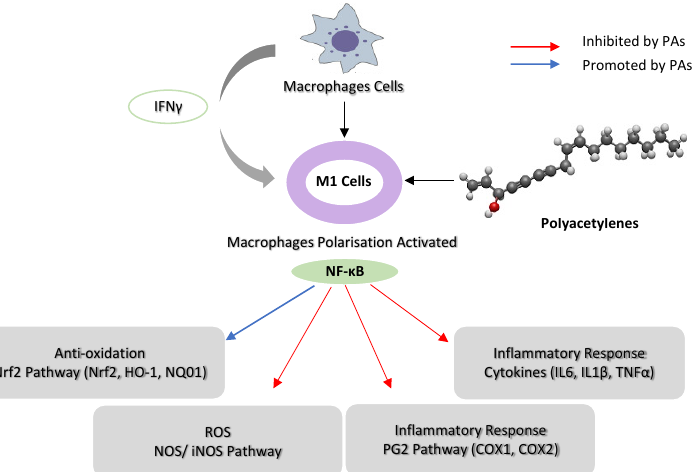
Figure 3. Schematic representation of the possible mechanism of immunoregulation activity of poly-acetylenes (PAs) in macrophages. (Interferon- γ ) IFN- γ activates macrophage cells to M1, and PAs downregulate NF- κ B activities in M1 macrophages by inhibiting iNOS, COX-1 and COX-2 . PAs suppress the inflammatory response by inhibiting cytokines ( IL-16, IL-1 β and TNF- α ) and upreg- ulating Nrf2 pathway ( HO-1 and NQO1 ) in macrophages. PAs structure modified from Mplanine (2022) https://www.wikiwand.com/en/Falcarinol#Media/File:Falcarinol_3D_BS.png (accessed on 1 January